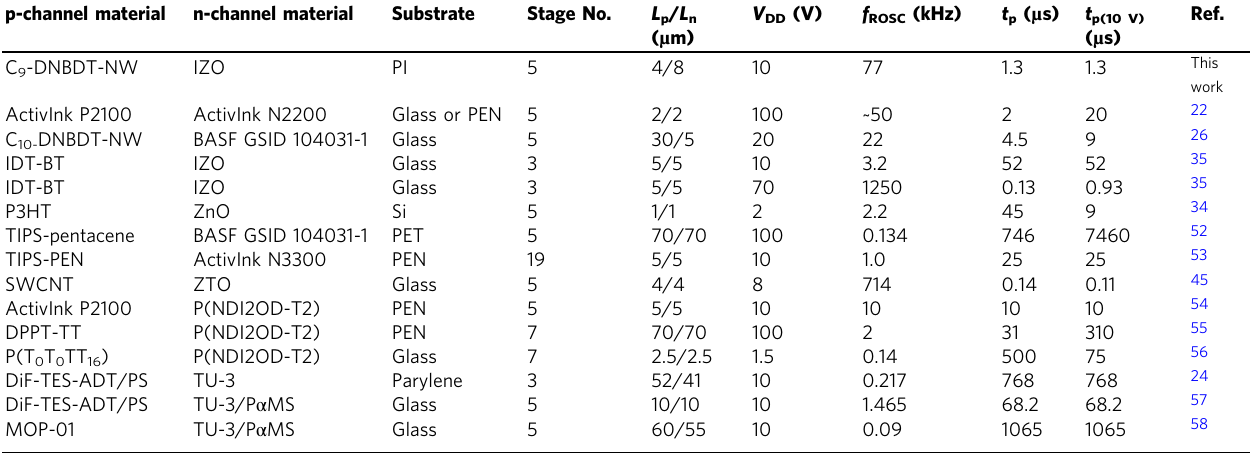
Table 1 Comparison of the stage-propagation delay in ring oscillators based on solution-processed MOSs and/or OSCs. p-channel material n-channel